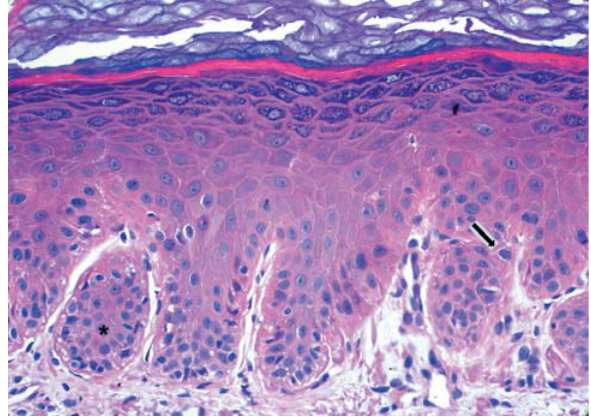
FIGURE 1 - Severe epithelial dysplasia in actinic cheilitis. Nuclear hyperchromatism of basal cells (arrow), nuclear polymorphism and rounded rete pegs (asterisk). HE ×200